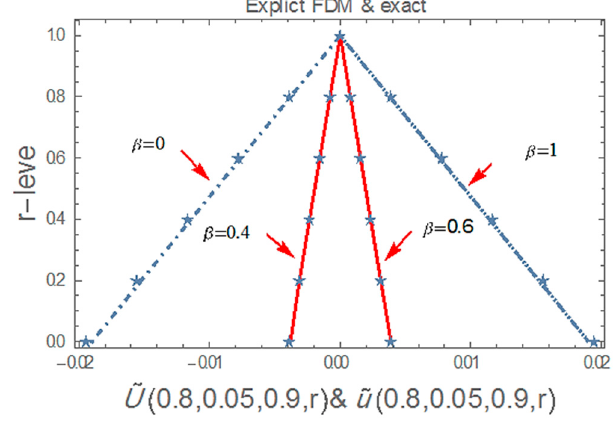
Figure 1. The fuzzy numerical solution of Equation (30), by using explicit finite difference at α = 0.9, x = 4, t = 0.05 for all r , β ∈ [ 0,1 ] .